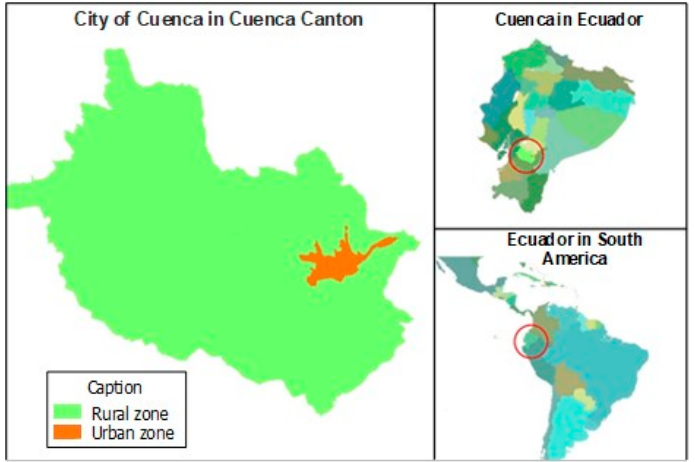
Figure 1. Spatial location of the Cuenca canton, urban area Approximately 2.28% (73 km 2 ) of the territory of Cuenca (3,190 km 2 ) is urbanized. By 2010, Cuenca had a population of 505,585 inhabitants, 329,928 living in the urban area (65%) and the remaining 35% in the headwaters of rural parishes and populations scat- tered within the cantonal territory. In the last census period (2001–2010), the urban popu- lation presented a 2.75% annual growth. Currently, the urban population is approxi- mately 400,000 inhabitants, according to projections.